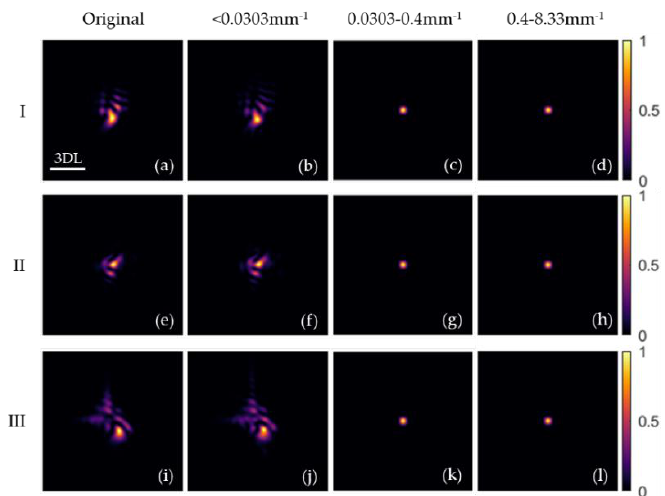
Figure 4. Focal spot shapes under different wavefront parts with PV = 2 λ . ( a – d ) represent the focal spots of the original, the low spatial frequency, PSD-1, and PSD-2 of type I , respectively, when the PV value of them all is 2 λ ; ( e – h ) and ( i – l ) represent the focal spots of type II and type III, respectively, same as ( a – d ). 3DL is a scale bar, and all subplots are the same size.